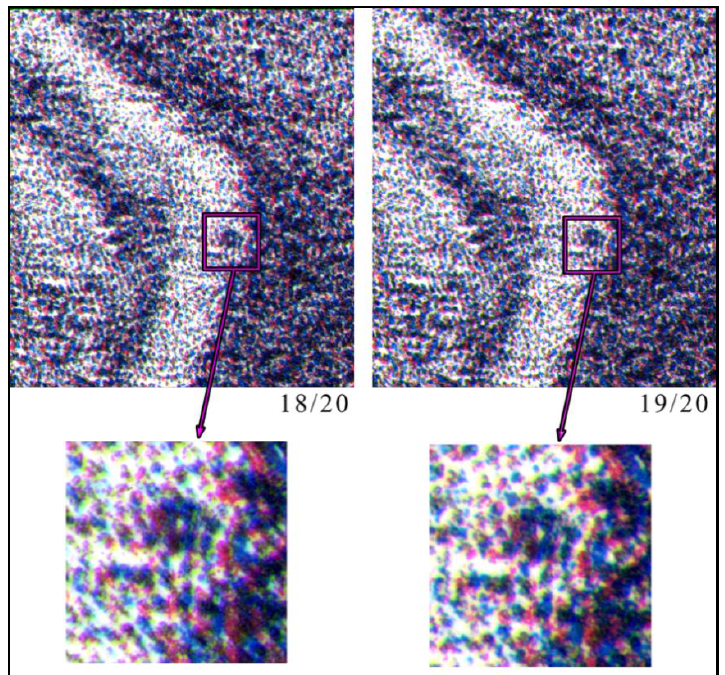
Figure 3. Particulars of two stone lithographs executed by the artist Giovanni Job (Dog 18/20 and Dog 19/20). One may see the slightly different distributions of colorful